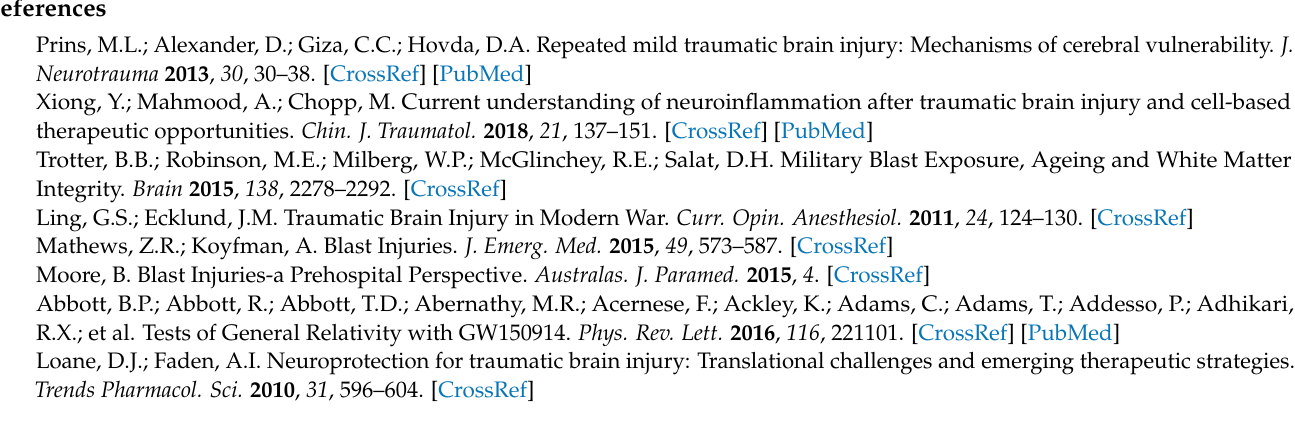
analyzed with varying flow rate of mobile phase 0.02% formic acid in water to acetonitrile (75:25) (a) 0.75 mL/min; retention time 2.6 min, (b) 0.5ml/min retention time 3.96 min; (c) 0.25 mL/min; retention time 7.98 min. Figure S5. Chromatogram of minocycline treated with (a) 1M sodium hydroxide; peak 1 degradant (1.42 min); peak 2 degradant (1.58 min), (b) 1 N Hydrochloric acid, peak 1 degradant (1.42 min); peak 2 Minocycline (2.036 min), (c) Hydrogen peroxide peak 1 degradant (1.53 min); and (d) light exposure Peak 1 Minocycline (2.15 min). Figure S6. Photo of the 9-inch square cross section, 22 ft long shock tube instrumented with pressure sensors. (B) Aerodynamic rat holder mounted in the test section (top), with rat placed on top (middle) and animal wrapped in a harness to minimize head and body motion during blast exposure (bottom). (C) Representative overpressure profiles as measured in the test section at the location of the animal’s head for 10 experimental groups used in our study. (D) The logistic regression dose-response model for rats exposed to single blast with intensity in the range of 60–450kPa peak overpressure (left) and corresponding impulse (90–780Pa · s right). Different levels of injury severities are determined based on survival. (E) Setup for behavioral study of anxiety and memory. Figure S7(a) Schematic of biodistribution experiment design; (b) Schematic of Nanoparticle localization experiment design; (c) Schematic of Behavioral and Neuroprotective study. Figure S8. Immunohistochemistry of Free minocycline, TMNP and NTMNP showed neuroprotection against blast induced neuronal cell death